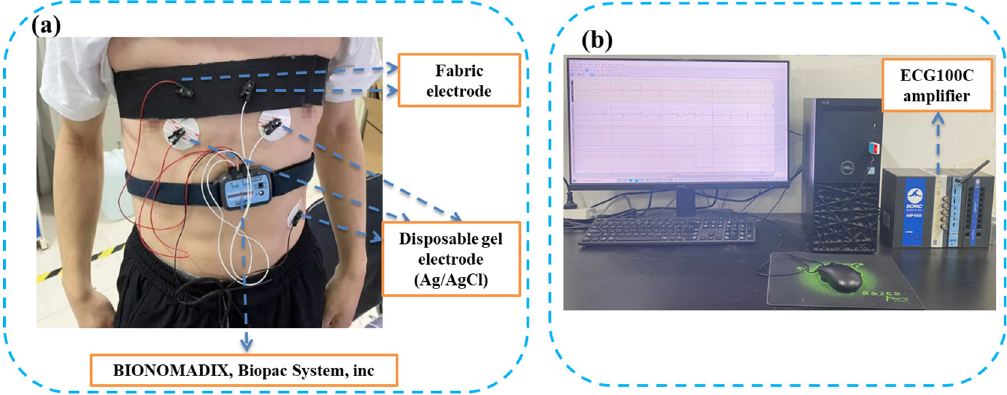
Figure 4 . ( a ) Human ECG test diagram. ( b ) Diagram of the ECG signal acquisition device. Figure 4. ( a ) Human ECG test diagram. ( b ) Diagram of the ECG signal acquisition